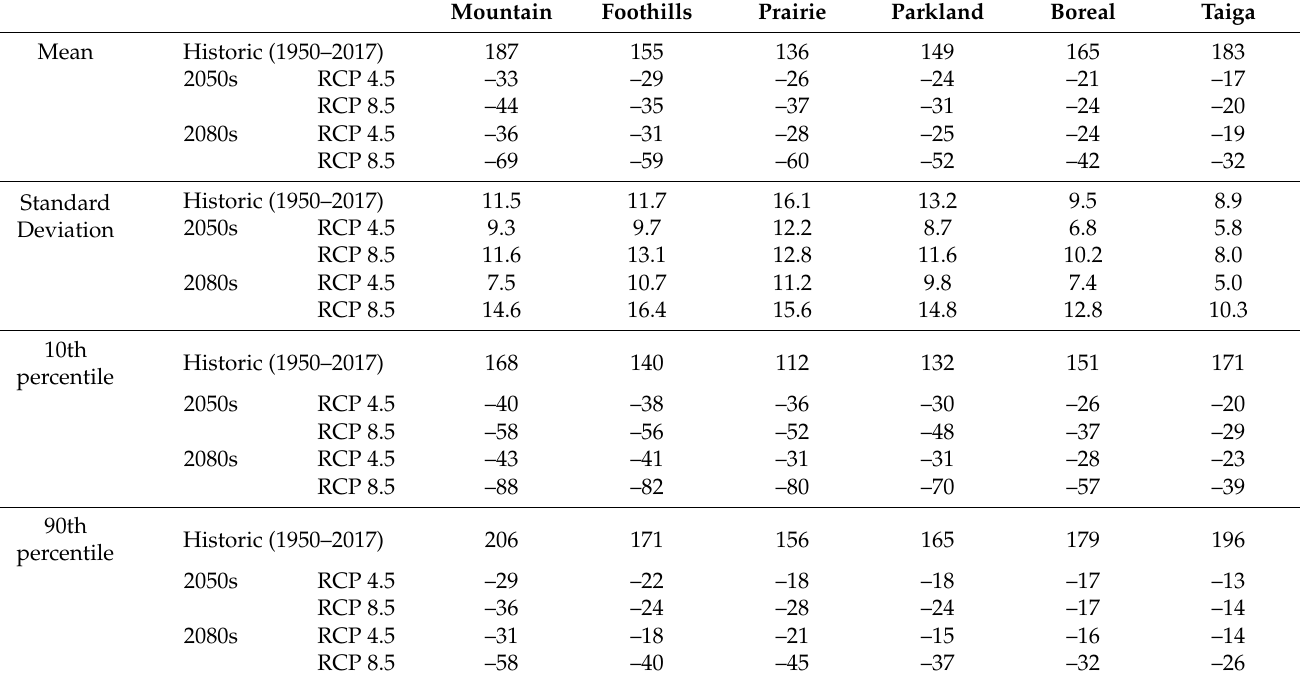
Table 4. Average change in winter duration given in as the change in the number of days between the historic baseline and future periods. Mountain Foothills Prairie Parkland Boreal